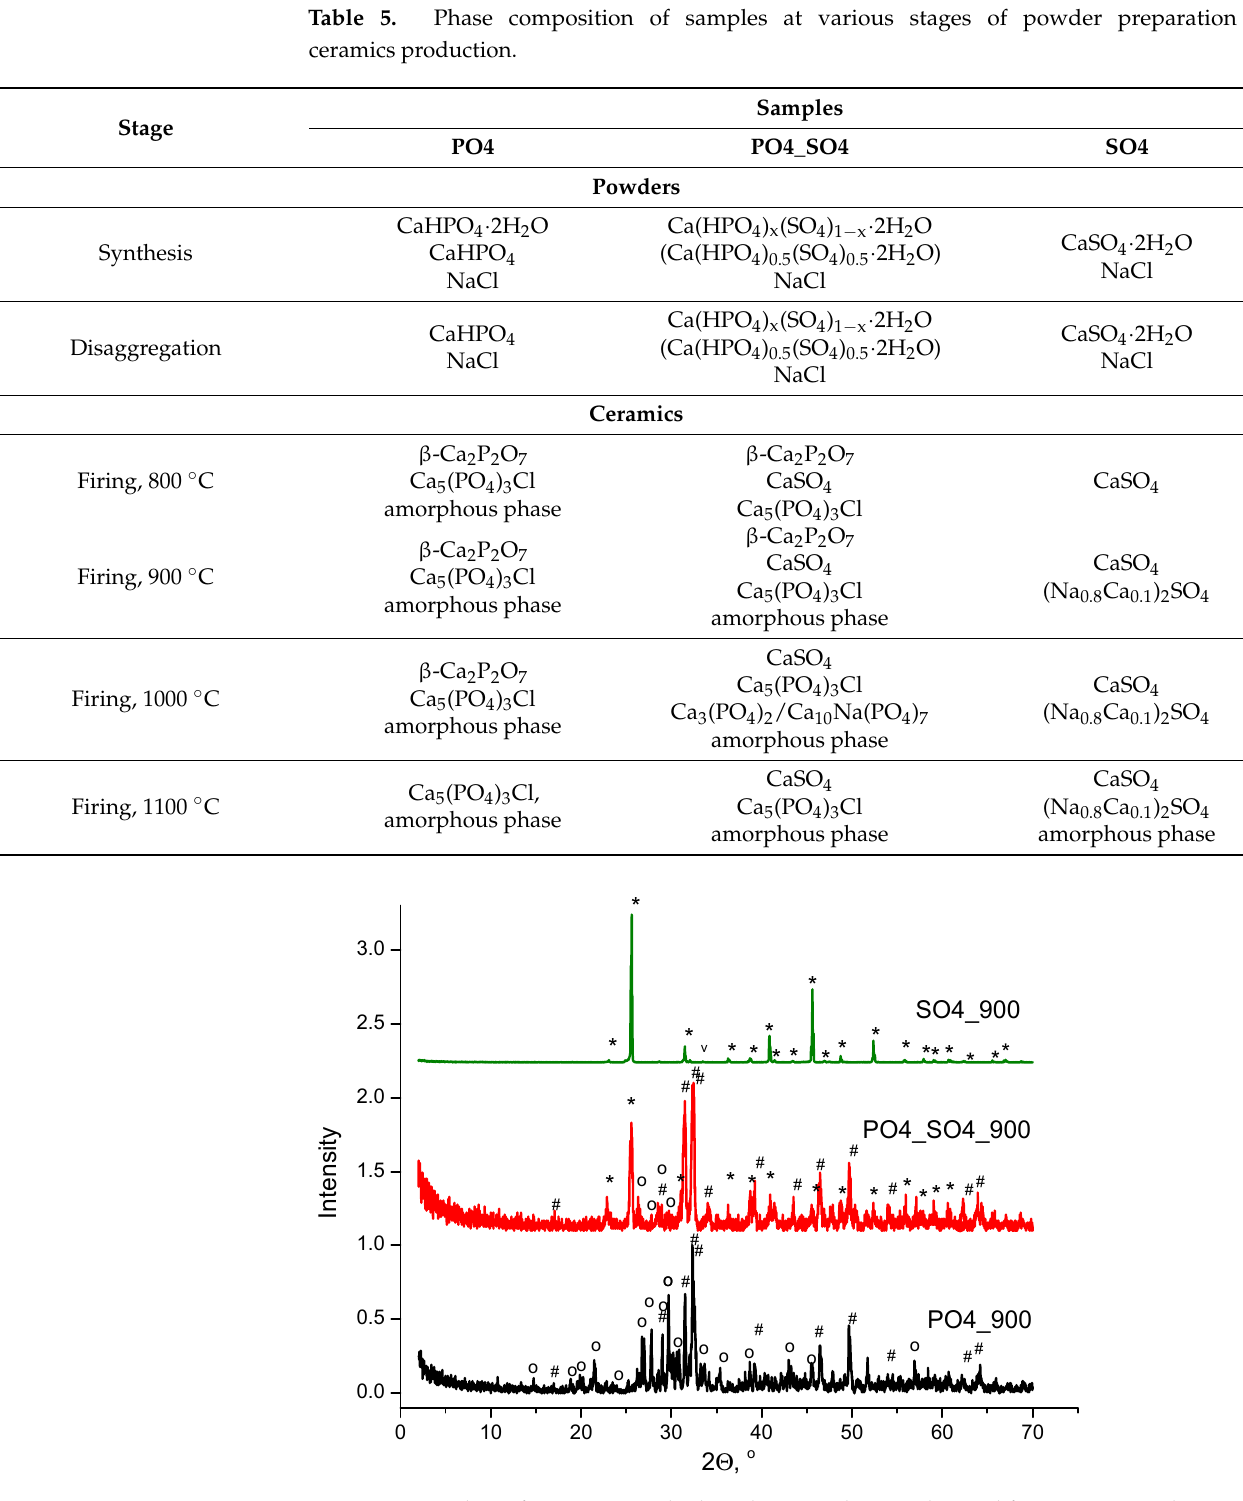
Figure 8. XRD data of ceramic samples based on powders synthesized from aqueous solution of calcium chloride CaCl 2 and sodium sulfate Na 2 SO 4 (green line); based on aqueous solutions of calcium chloride CaCl 2 and sodium hydrophosphate Na 2 HPO 4 (black line); and based on aqueous solutions of calcium chloride CaCl 2 and mixed-anionic solution Na 2 HPO 4 /Na 2 SO 4 (red line) after firing at 900 °C: *—CaSO 4 (card PDF 37-1496); v—(Na 0.8 Ca 0.1 ) 2 SO 4 (card PDF 29-1126); #—Ca 5 (PO 4 ) 3 Cl (card PDF 73-1728); o— β - С a 2 P 2 O 7 ( карточка PDF 9-346).